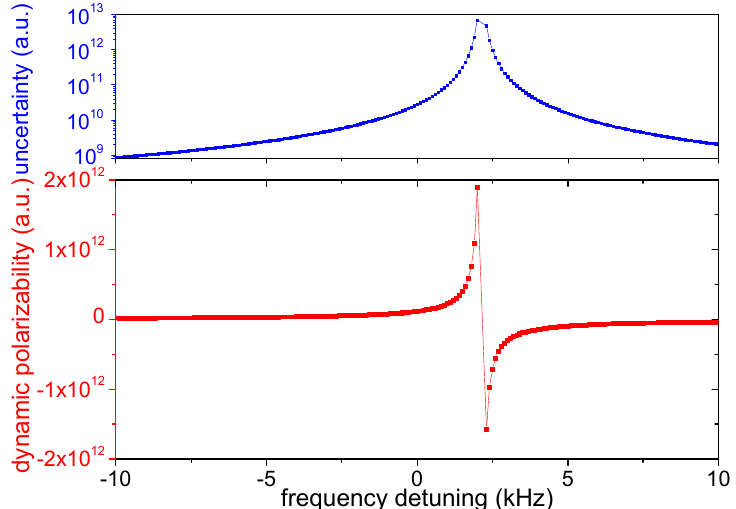
Figure 2. Standard dynamic polarizability σ + (red) and its uncertainty (blue) of the stretched state |v, L, F, S, J, J z > = |0, 0, 1, 2, 2, 2> as a function of the frequency detuning to 1,314,945,902.3 kHz (the hyperfine resonance |v, L, F, S, J> = |0, 0, 1, 2, 2> → |0, 1, 1, 2, 3> at zero-magnetic field). Magnetic field: 10 − 4 T.